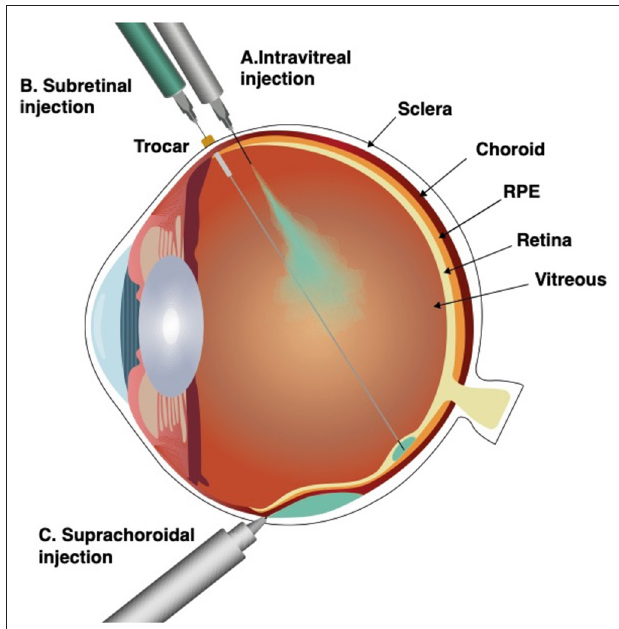
FIGURE 1 | Surgical approaches for subretinal delivery. Intravitreal injection (A), subretinal injection (B), and suprachoroidal injection through a microneedle (C). Intravitreal injection fills the vitreous body and exposes all intraocular surfaces in contact with the vitreous to the vectors or cells. Subretinal injection, delivers the therapeutic suspension immediately under the sensory retina, into the subretinal space, a virtual space between the photoreceptors and the retinal pigment epithelium (RPE). Suprachoroidal injection by a microneedle, delivers the therapeutic suspension into to the suprachoroidal space, a virtual space between choroid and